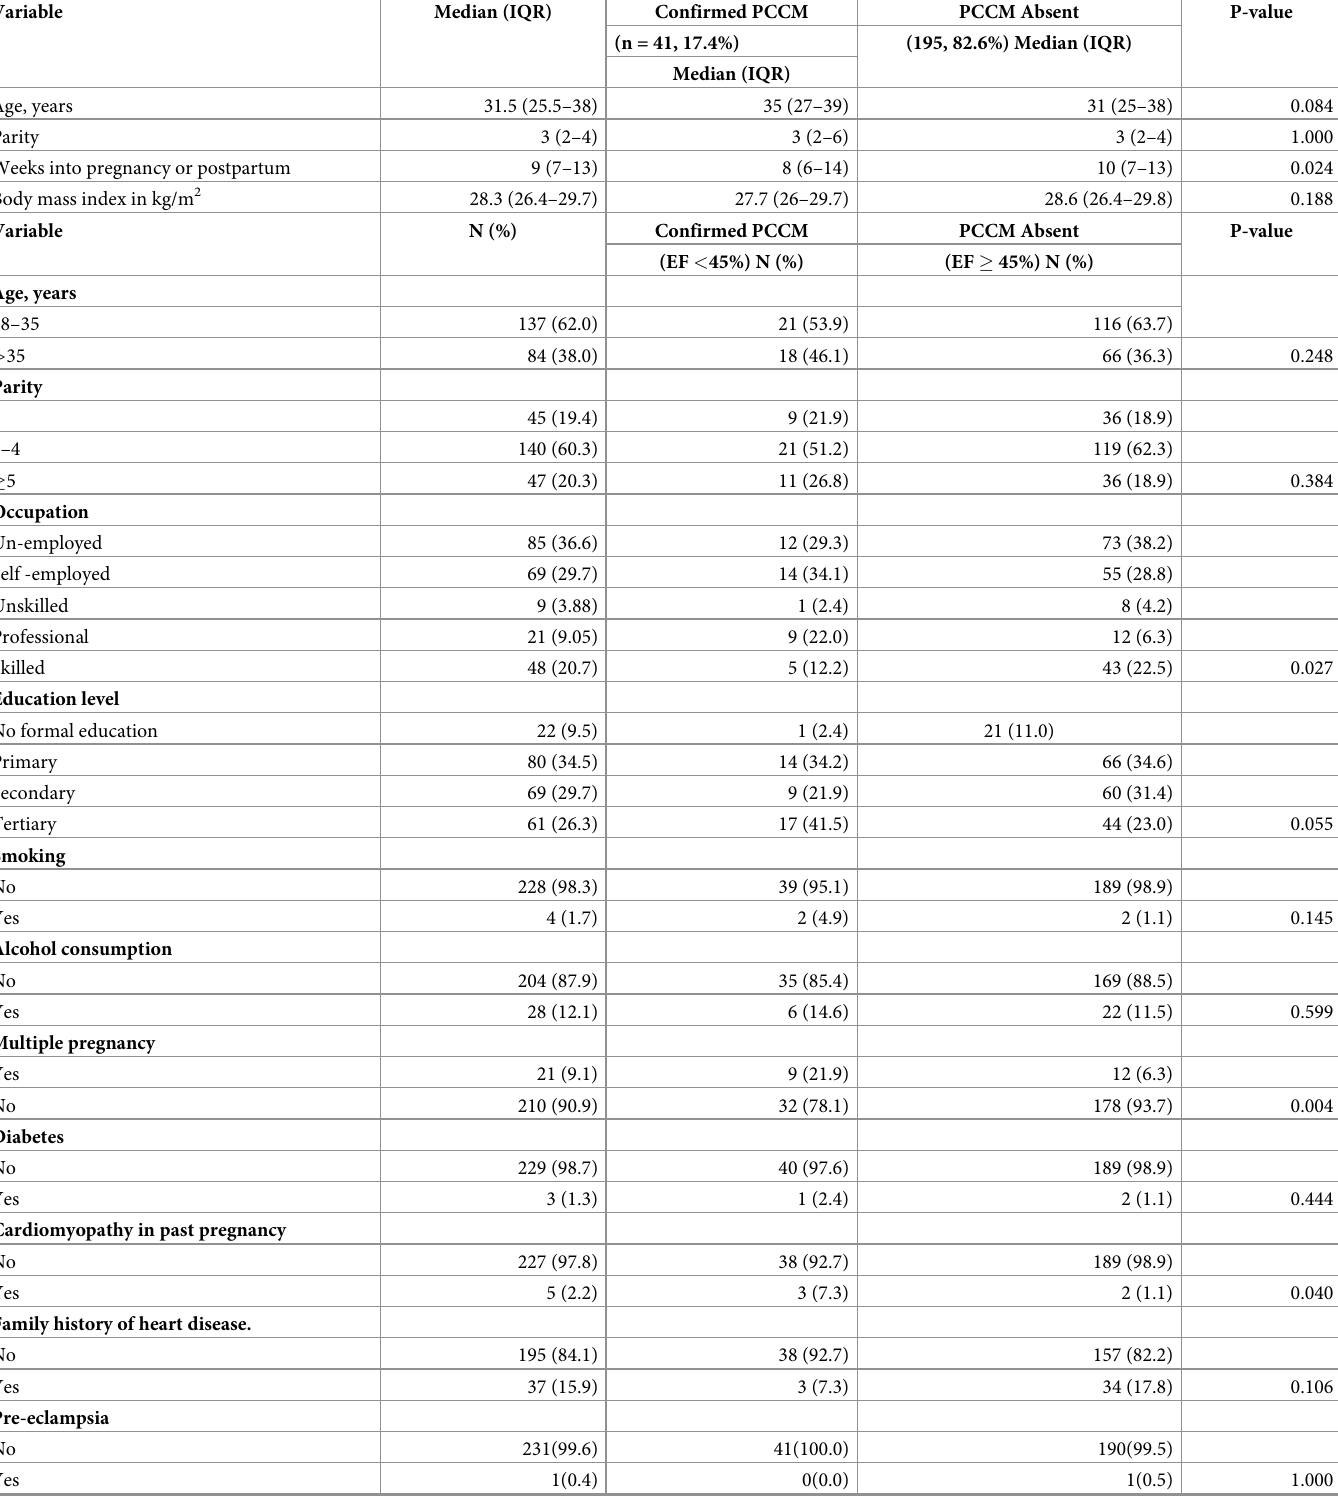
Table 1. Baseline socio-demographic and clinical characteristics of the study